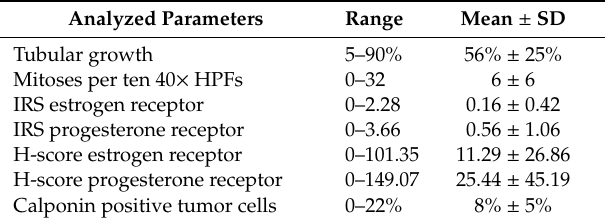
Table 2. Results of histological and immunohistochemical